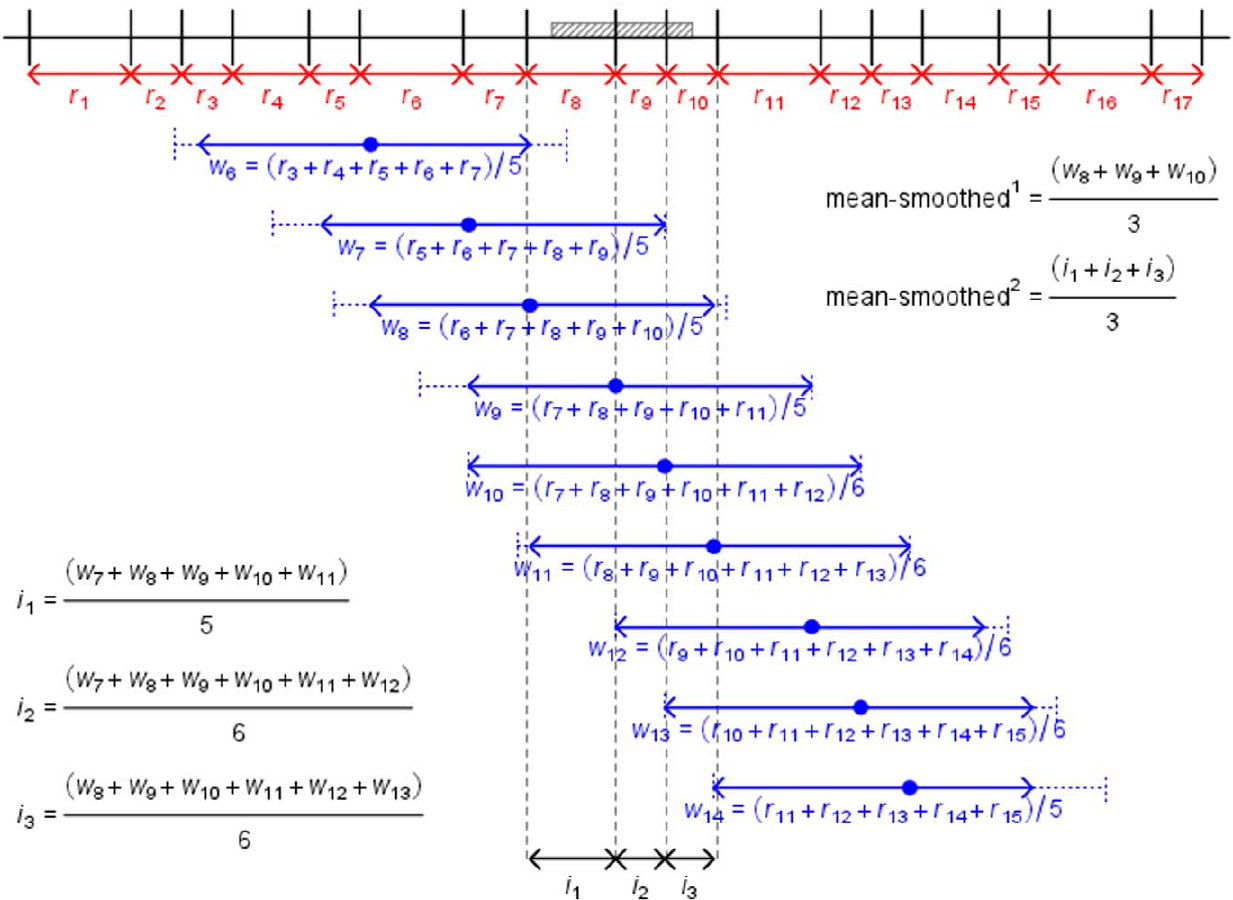
Figure 2. Methodologies used to generate smoothed recombination rates. Representation of methods used to calculate smoothed recombination rates (method 4.2.4). Note that this diagram is for descriptive purposes only and is not to scale. For simplicity, only calculations for mean rates are shown. The grey region is a gene. Vertical black lines are SNP markers. In red are recombination rates between pairs of neighbouring markers ( r x ). Dashed blue lines represent 1 Mb windows either side of a focal SNP. Solid blue arrows represent all intervals within this window, over which recombination rates are averaged ( w x , averaged-smoothed 1 ). For three intervals, averages of all window averages covering the interval are shown (i x , average-smoothed 2 ). doi:10.1371/journal.pone.0024480.g002 PLoS ONE |